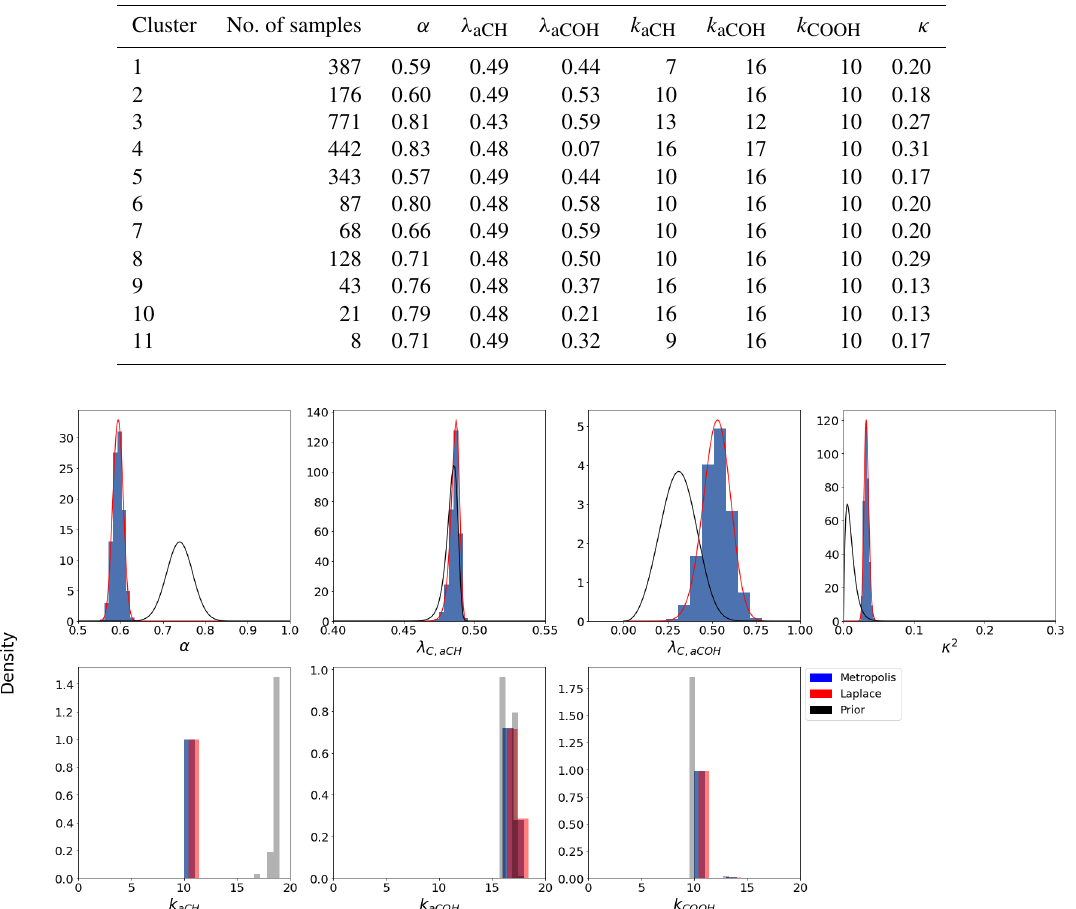
Figure 5. Example posterior distribution of cluster 2 from MCMC. Dark lines correspond to prior distributions, blue histograms correspond to sampled posterior distributions, and red lines correspond to Laplace estimation. “Density” refers to the probability or mass density and the variables are described in Sects. 1.1 and 3.2. Nonparametric densities are approximated by kernel density estimation (Hastie et al., 2009), shown in the top row of this